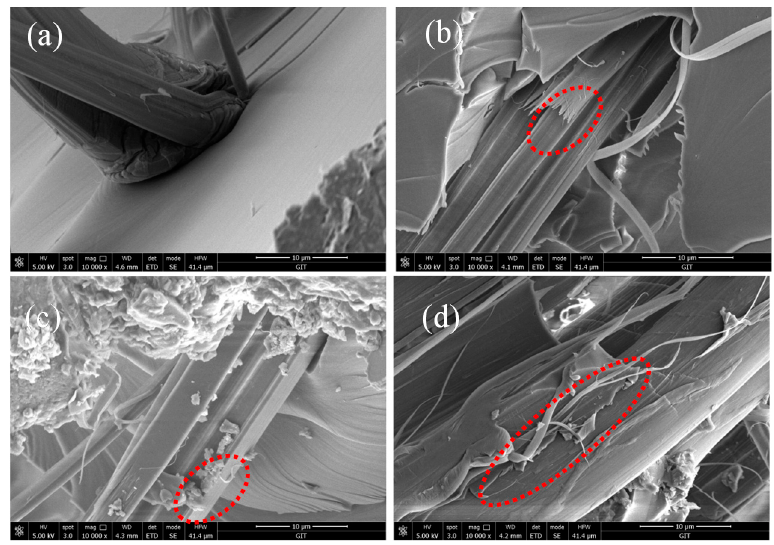
Figure 15. SEM images of AF/EP composites before and after modification. ( a ) AF0; ( b ) AF1; ( c ) AF2; ( d ) AF3.